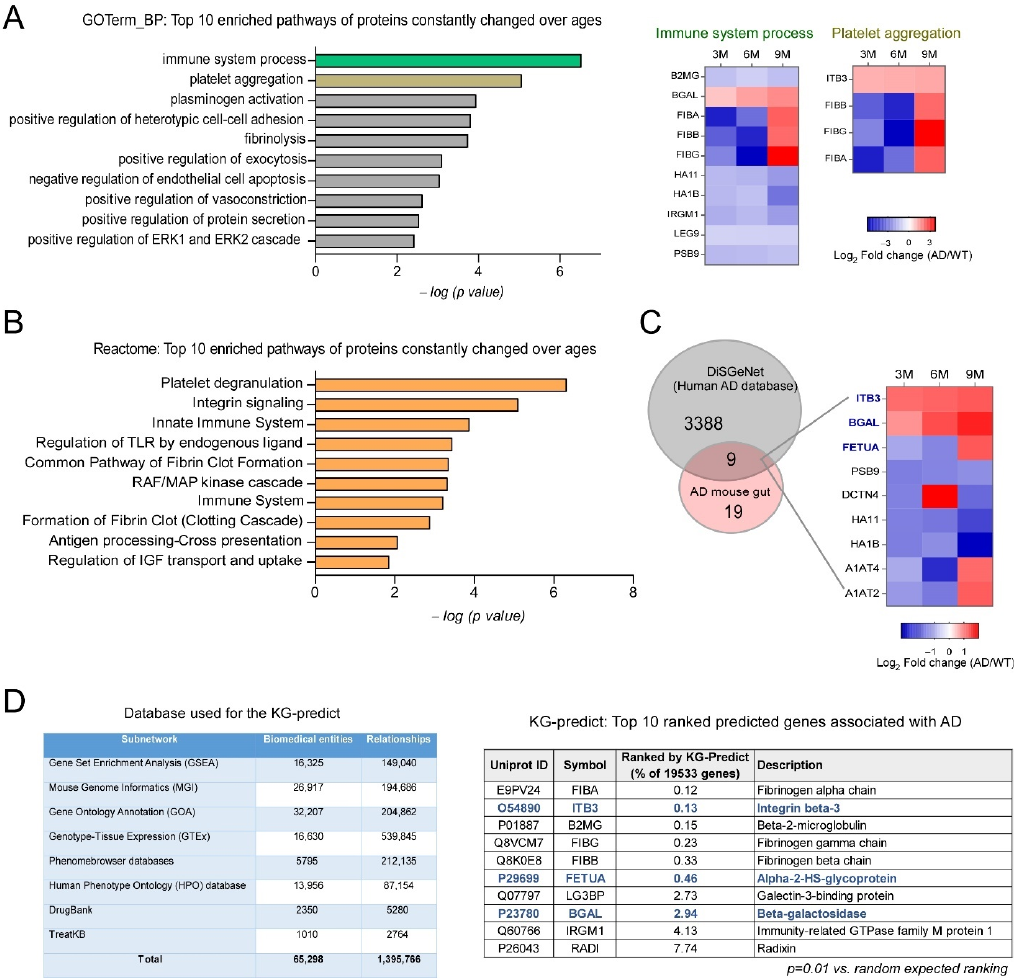
Figure 3. Tracking colonic proteins associated with AD concomitant with disease progression.